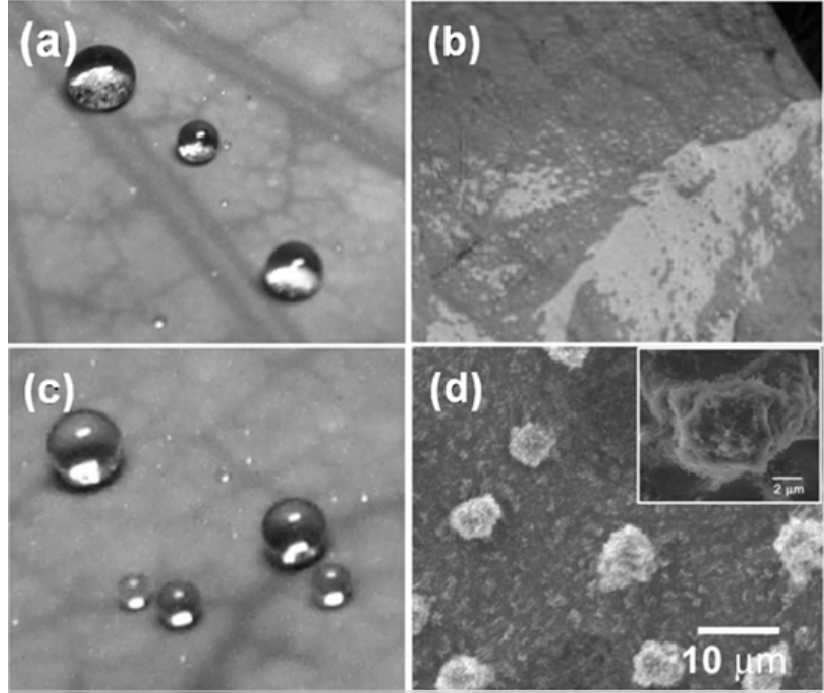
Figure 6. Photographs of lotus surfaces: ( a ) untreated; ( b ) immersed in water at the depth of 50 cm for 2 h; ( c ) dried by nitrogen gas after being immersed; ( d ) ESEM images of microstructures. Images reprinted from [61], with permission from the American Chemical Society, Copyright